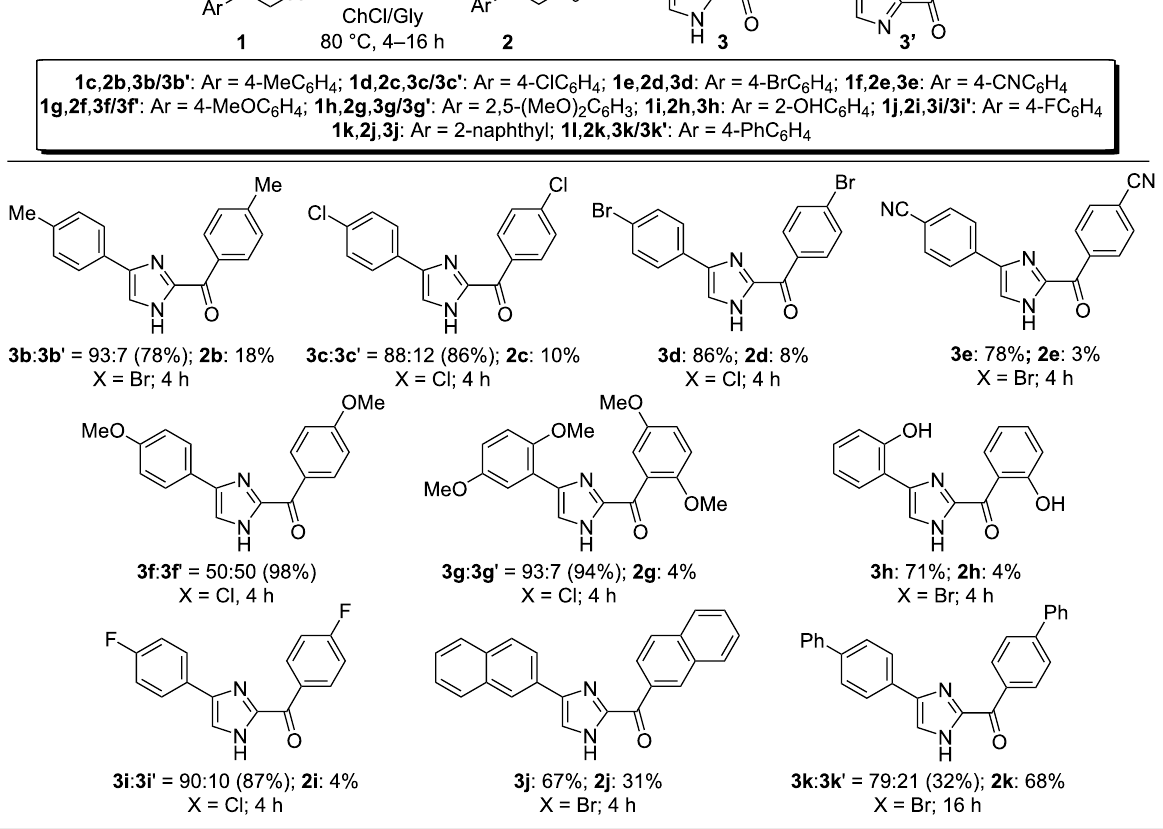
Scheme 3: Synthesis of 2-aroyl-(4 or 5)-aryl-(1 H )-imidazoles 3 . Scope of the reaction. Typical conditions: 1 (0.5 mmol), NaN 3 (0.75 mmol), ChCl/Gly (1.0 g), 80 °C, 4–16 h; yield refers to products isolated after column chromatography on silica gel; only one tautomer has been depicted for simplicity;